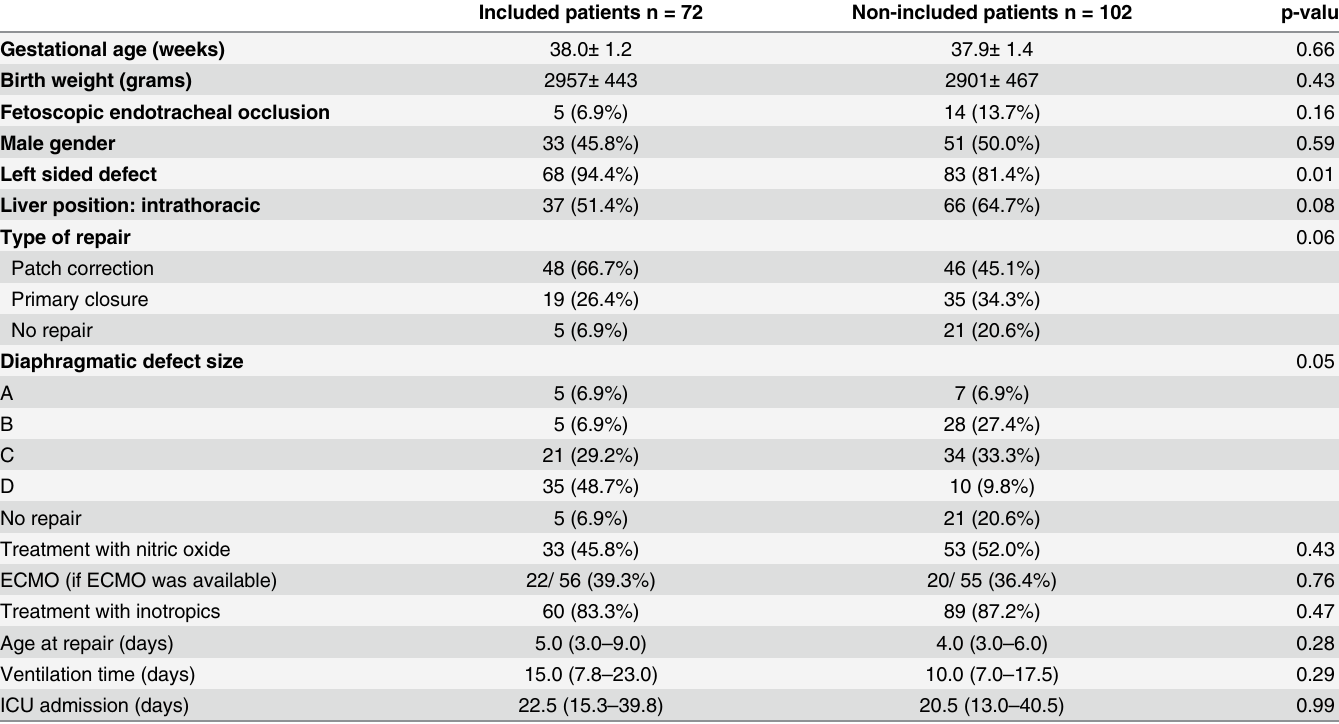
Table 1. Patient